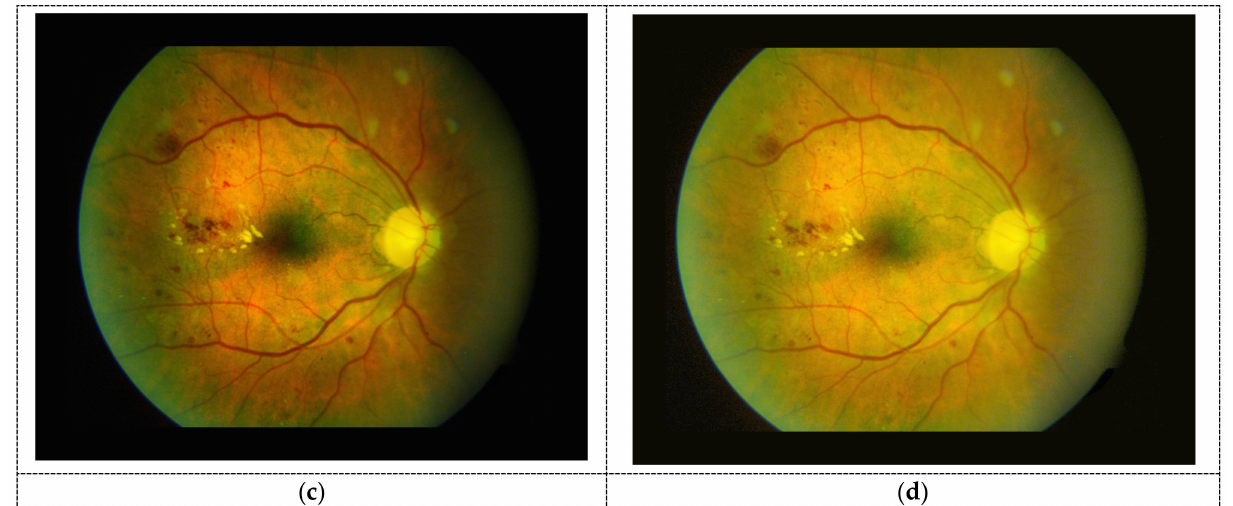
Figure 3. Illustration of preprocessing for hemorrhage candidate and feature extraction, ( a ) original RGB image, ( b ) bright- ness adjustment behavior for different values of gamma, ( c ) contrast-enhanced image, ( d ) brightness adjustment using adaptive gamma